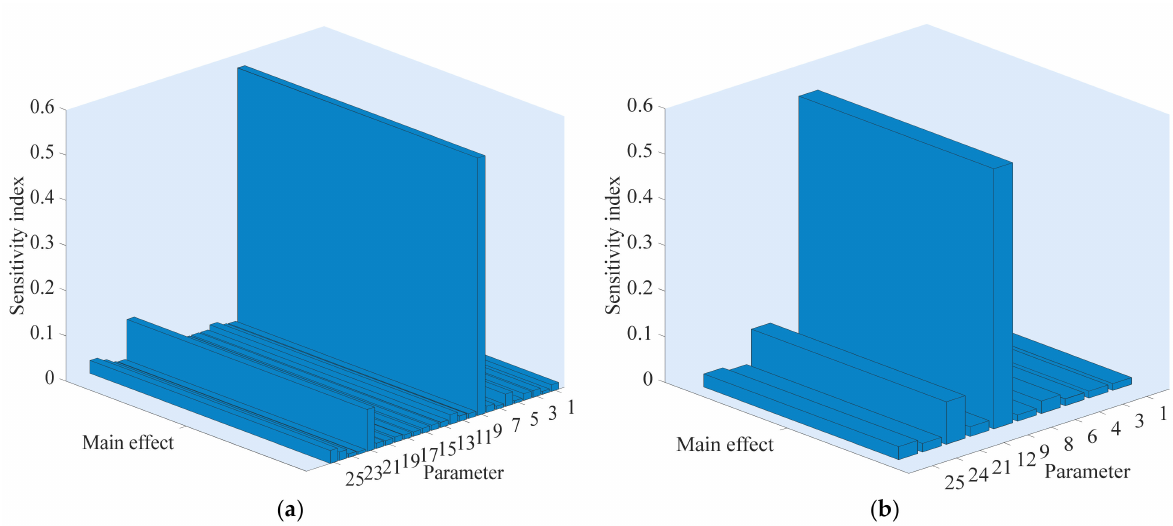
Figure 15. The sensitivity index of parameters of the rise time of the angular velocity. ( a ) The sensitivity index of 25 parameters; ( b ) The sensitivity index of the top 10 parameters. The numbers 1 to 25 represent symbols T , Kp , b p , K d , A t , D t , f p , q nl , T 0 , T d0 , T d00 , T q00 , H , F , K a , R s , L ls , R r , L lr , L m , H 1 , F 1 , WS , Ncellm12 and I r , respectively. For the physical meaning and definitions of these parameters, see Appendix B.